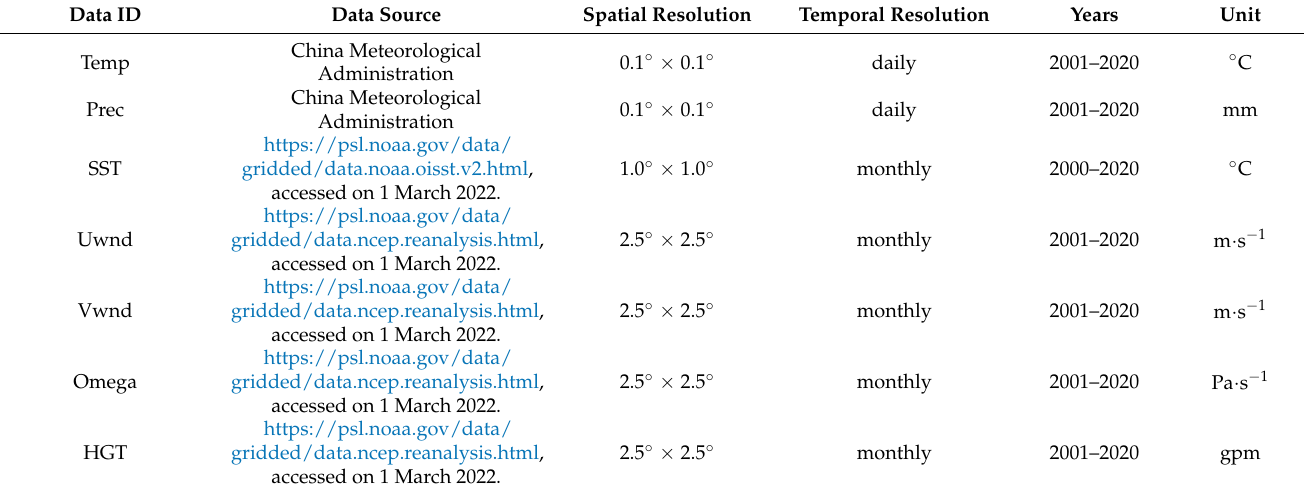
Table 1. The climate datasets used in this study.